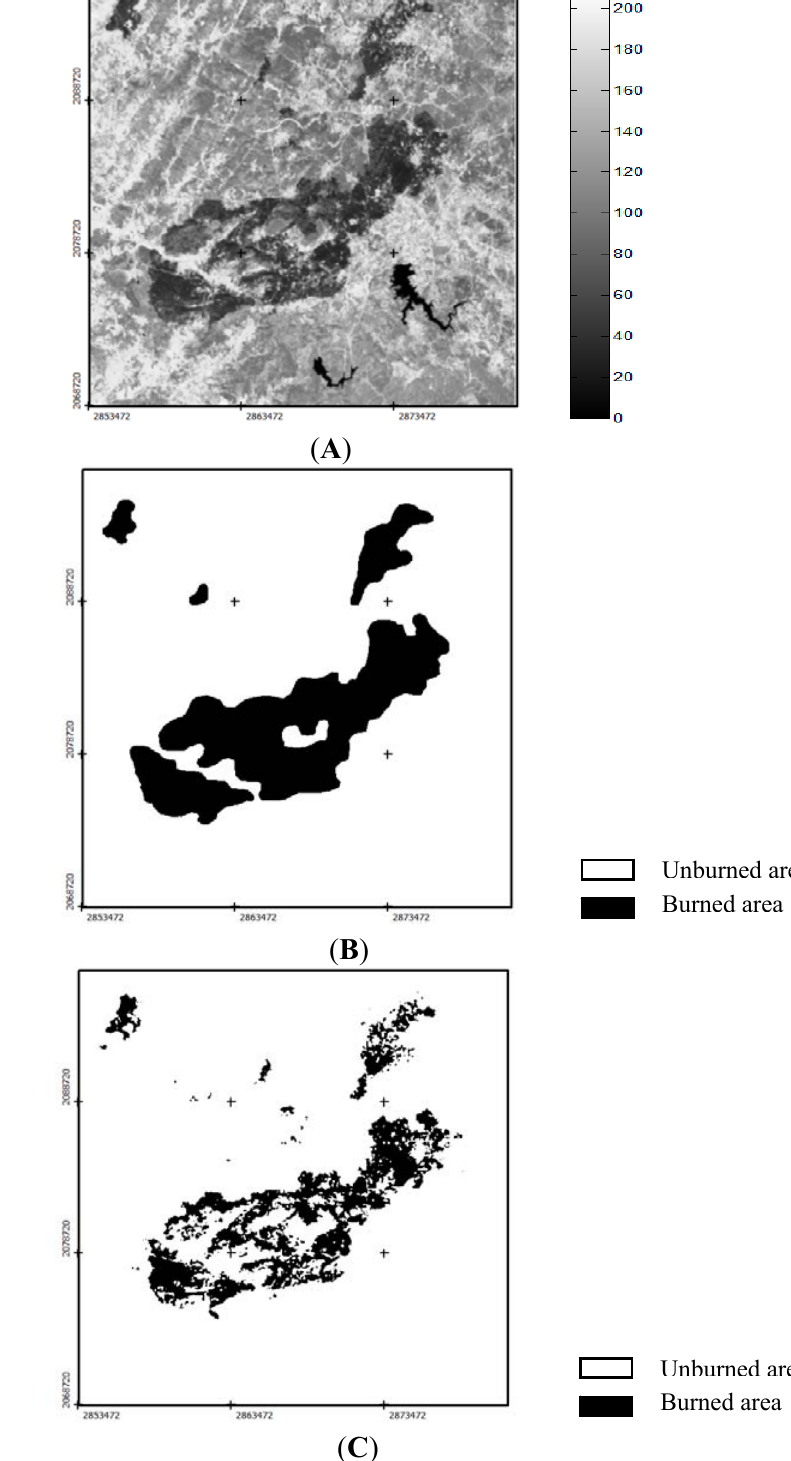
Figure 5. Difference in burned area estimation. Snapshots in northern Portugal (ETRS89/ LAEA projection) corresponding to ( A ) Near infrared IRS-AWiFS; ( B ) EFFIS-RDA burned scar; ( C ) IRS-AWiFS-based burned